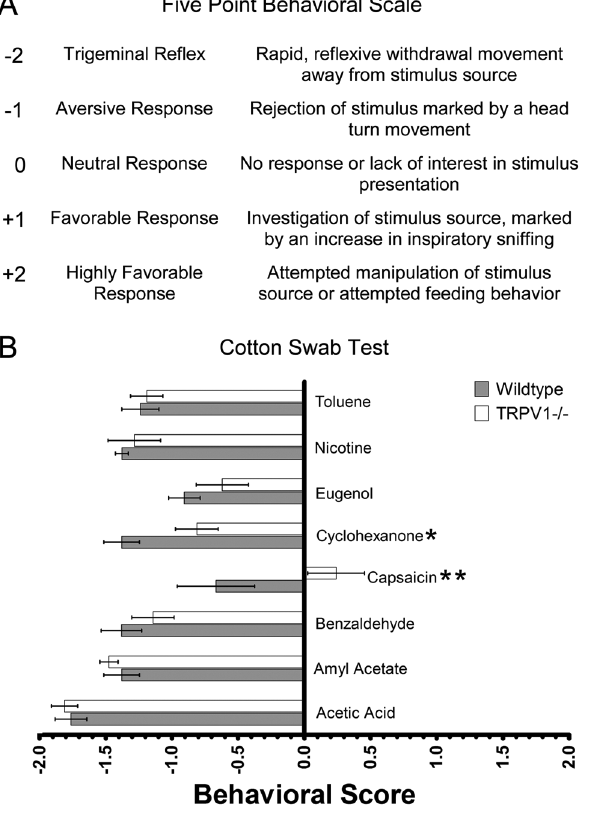
Figure 2. TRPV1 knockout mice are significantly less averse to capsaicin and cyclohexanone than wildtype mice in an acute presentation. ( A ) A five-point scale ranging from -2 for a trigeminal reflex to +2 for a highly favorable response was used to assign behavioral scores for each substance. ( B ) Mean ± SEM behavioral score for wildtype mice ( n =7), filled bars, and TRPV1-/- knockout mice ( n =7), unfilled bars. Two-way ANOVA revealed a significant difference among irritants ( P <0.001), genotype ( P <0.01) and a significant interaction between irritant and genotype ( P <0.05). Knockout mice had a significantly more favorable response to capsaicin ( P <0.01) and cyclohexanone ( P <0.05) than wildtype mice. *P<0.05, **P<0.01, ***P<0.001.